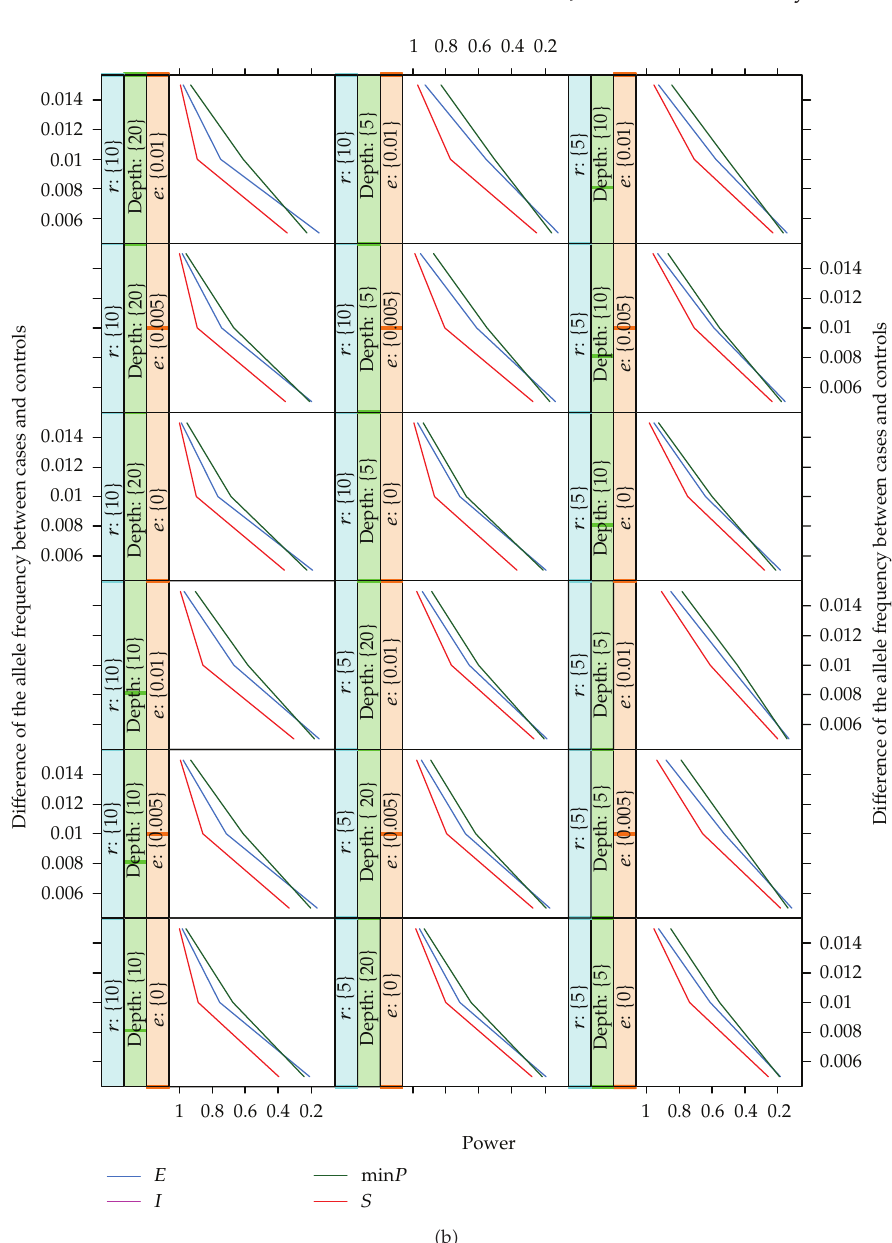
Figure 2: Empirical power at a level of 5% as a function of the di ff erence of the allele frequency between cases and controls for the proposed PB test based on various estimates of the covariance matrix for testing multiple rare variants under the unbalanced design. The allele frequency of controls was 0.01; the sample size was set at 500 cases and 500 controls; the error rates (cid:2) e (cid:3) were set at 0, 0.005, and 0.01; the depths of coverage were set at 10 × and 20 × , and the numbers of pools (cid:2) r (cid:3) were set at 5 and 10. Figure (cid:2) a (cid:3) shows the power of the PB test based on an identity covariance matrix (cid:2) I (cid:3) , the PB test based on the shrinkage estimate of the covariance matrix (cid:2) S (cid:3) and the single-variant test with Bonferroni correction the number of variants for independent variants (cid:2) min P (cid:3) . Figure (cid:2) b (cid:3) shows the power of the PB test based on the empirical estimate of the covariance matrix (cid:2) E (cid:3) , the PB test based on the shrinkage estimate of the covariance matrix (cid:2) S (cid:3) and the single-variant test with Bonferroni correction (cid:2) min P (cid:3) the number of variants for independent